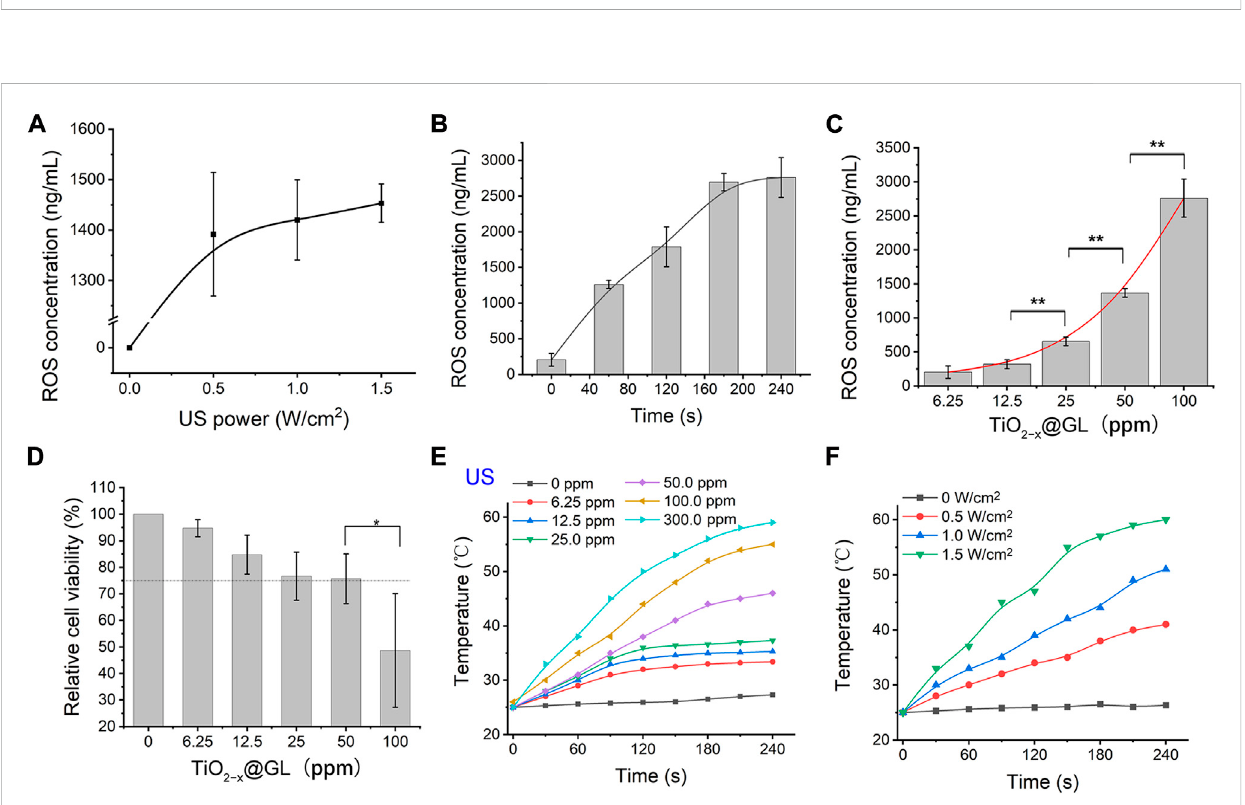
FIGURE 3 In vitro sonodynamic and photothermal effects of TiO 2 − x @GL. (A) ROS generation behavior of TiO 2 − x @GL under different ultrasonic intensities invitro . (B) CumulativeROSconcentrationcurveofTiO 2 − x @GLsubjectedtocontinuous ultrasoundirradiation(1.5 W/cm 2 ). (C) Comparison oftheeffects of different particle concentrations on the ROS generation. (D) Cytotoxicities of various concentration of TiO 2 − x @GL to normal epithelial cells. (E) Elevated concentrations (0, 6.25, 12.5, 25, 50, 100, and 300 ppm) of TiO 2-x @GL irradiated by NIR-II (1064 nm) at a power intensity of 1.5 W/cm 2 . (F) Photothermal heating curves of 50 ppm TiO 2 − x @GL irradiated at varied power densities (0, 0.5, 1.0, and 1.5 W/cm 2